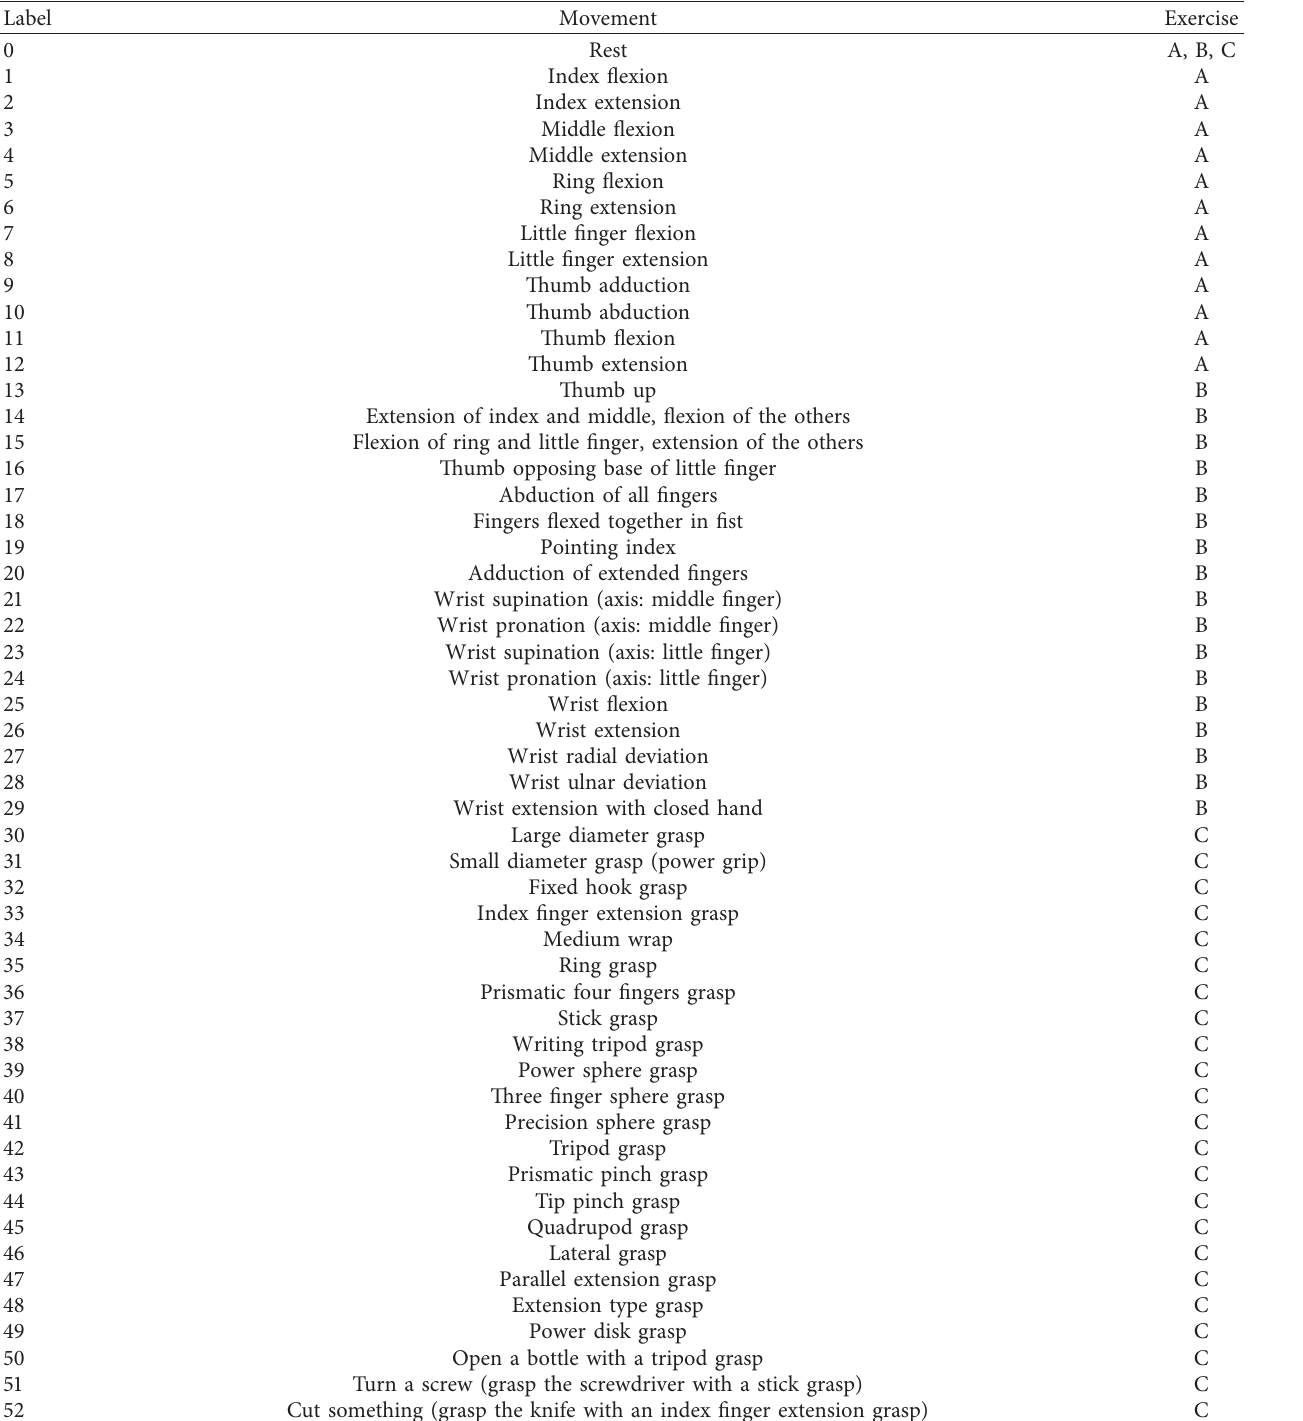
Table 1: Ninapro